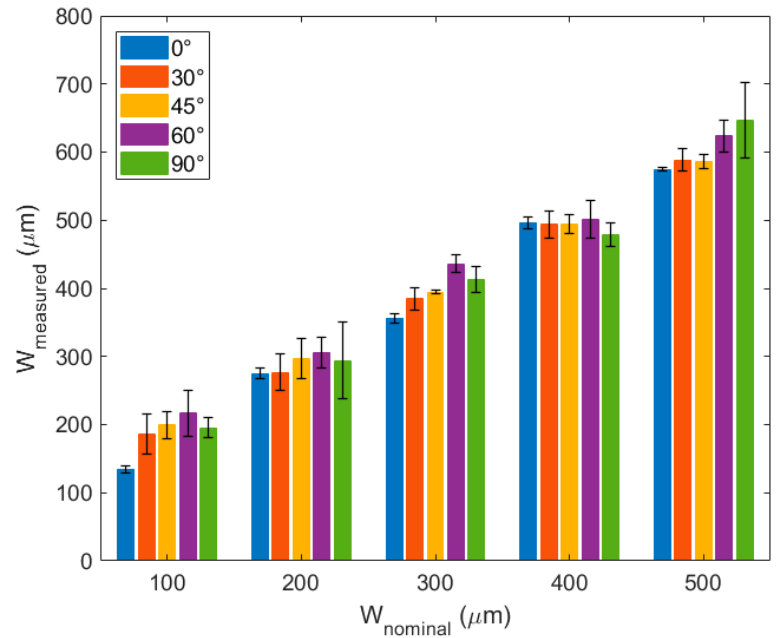
Figure 4. Comparison of the measured and nominal widths of the printed lines as a function of the line angles and nominal widths.